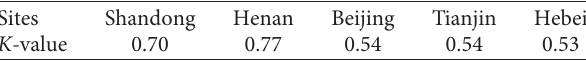
Table 3: The annual humidity index ( K ) from 1961 to 2014 in each